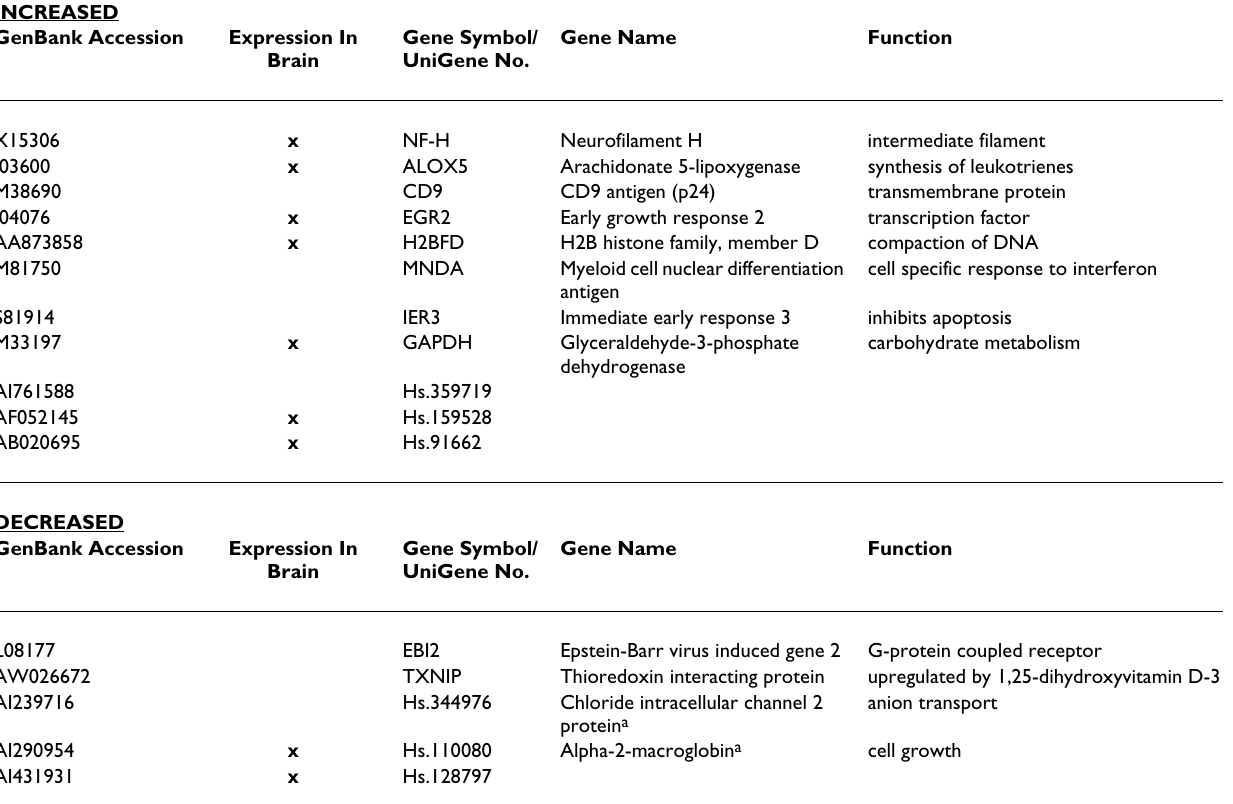
Table 4: Genes with increased and decreased levels of expression in at least 15 of 20 comparisonsbetween 4 mutant MeCP2 expressing LCLs and 5 wild type MeCP2 expressing LCLs INCREASED GenBank Accession Expression In Gene Symbol/ Brain UniGene